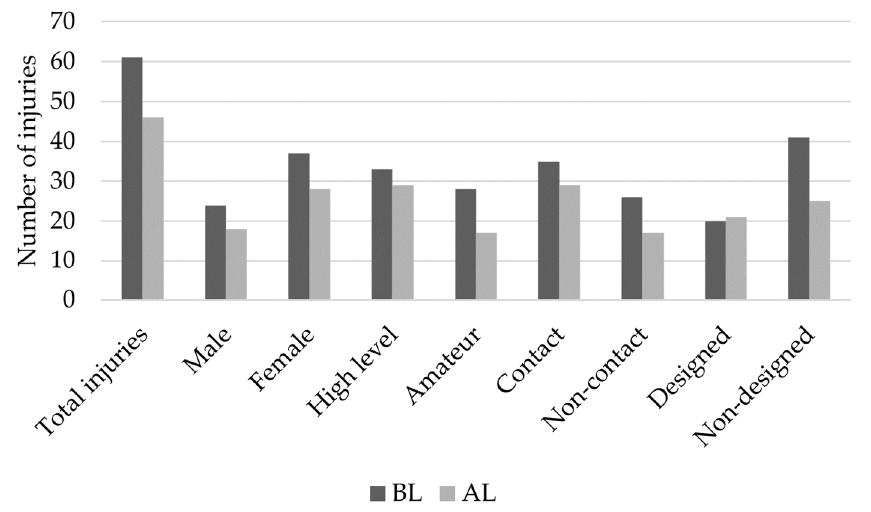
Figure 1. Number of injuries (BL and AL) for the different levels of examined variables. When differences between the two levels were compared (Table 3), the results showed no significant differences in the IR BL and AL between contact and non-contact sports. There were no significant differences between professionally-designed and non-designed training DL. Furthermore, high-level athletes suffered significantly more injuries than amateur athletes BL, but there were no significant differences between them AL. All effect sizes were small ( r <